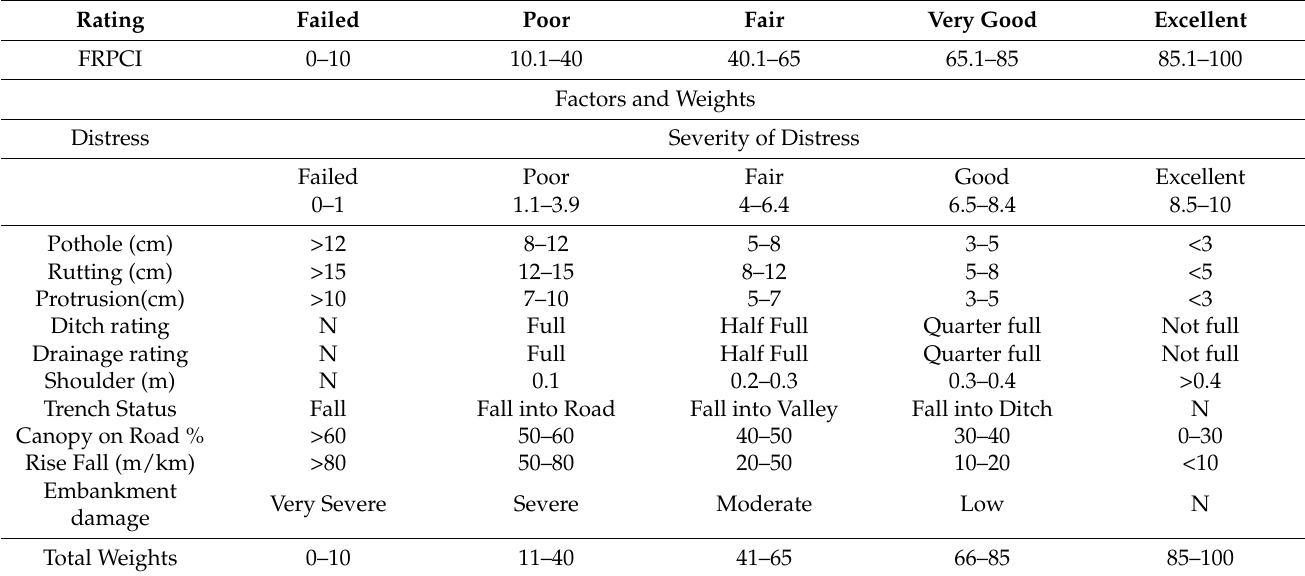
Table 2. Forest Road Pavement Condition Index Calculating.